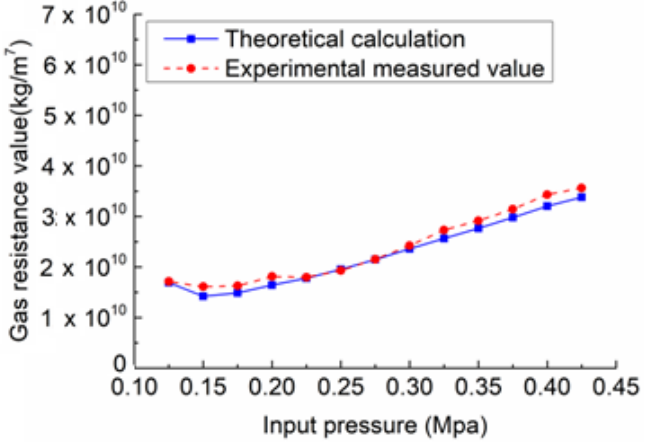
Figure 8. Comparison curve between the theoretical and experimental values of the gas resistance and input pressure of the tube with an inner diameter of 4 mm and tube of 0.5 m.